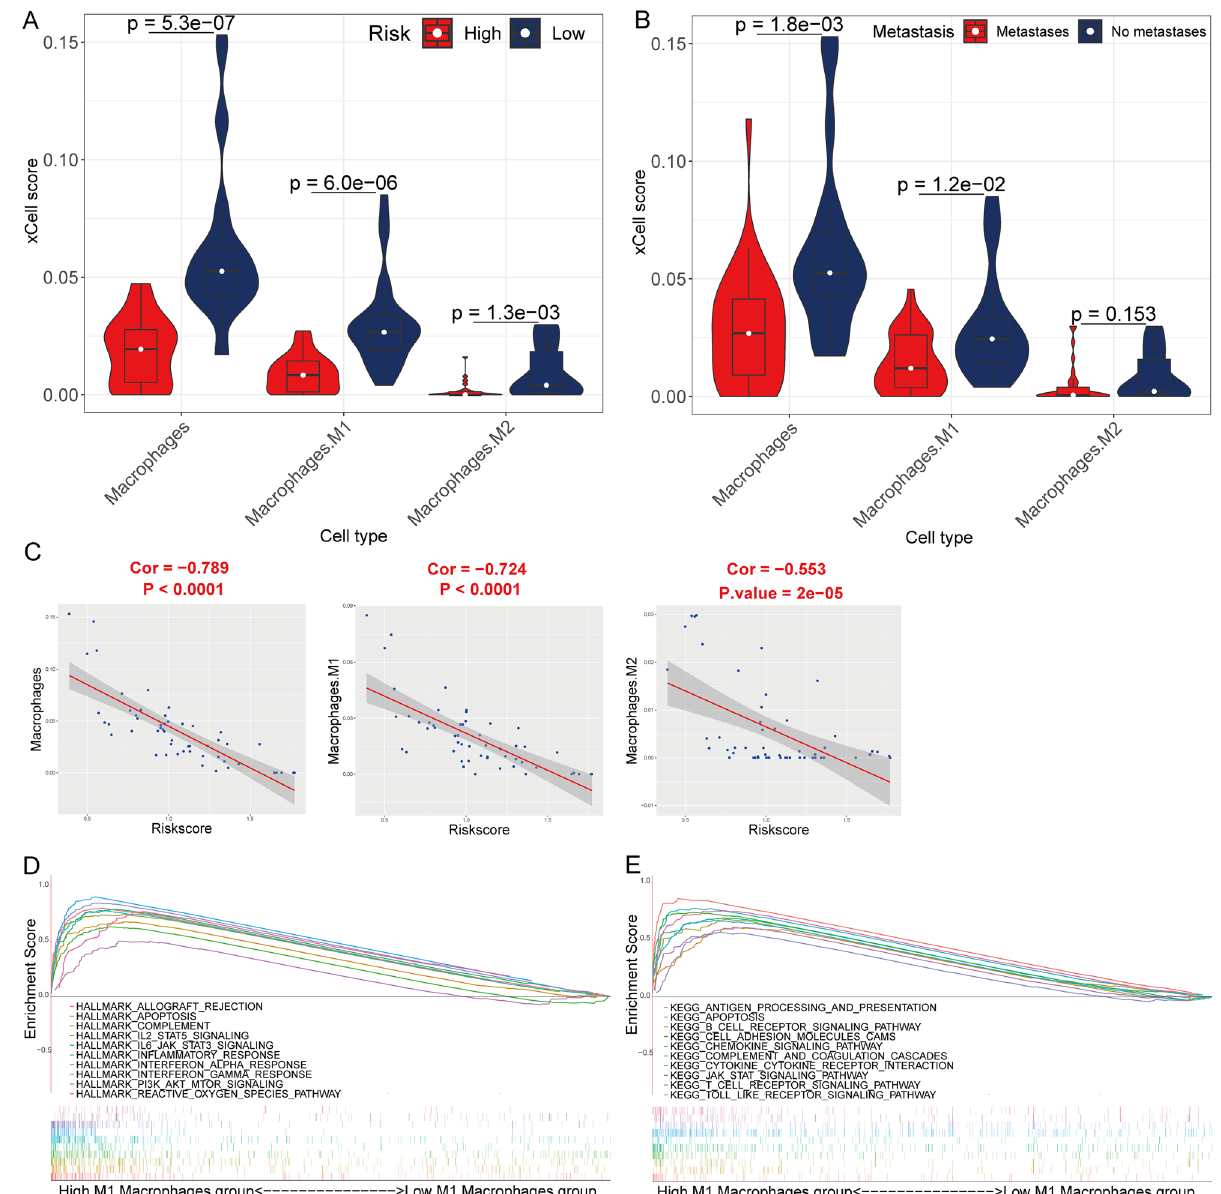
cohort. ( B ) Comparison of xCell score of the five prognostic related immune cells between the metastatic and non-metastatic group in the GSE21257 cohort. ( C ) The correlation between the risk score and xCell score